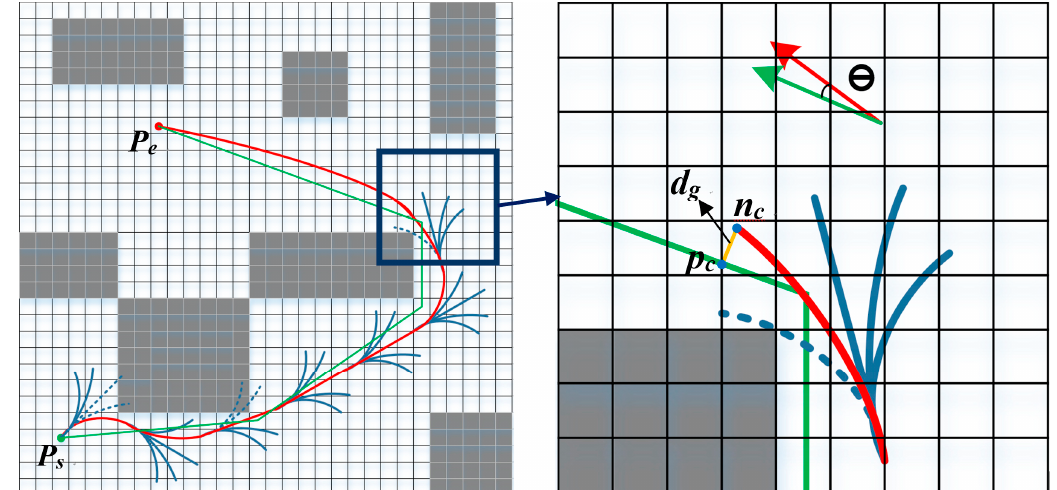
Figure 4. An illustration of the mechanism of the guided kinodynamic path searching (GKPS) method. Blue curves indicate the motion primitives generated by Equation (3). The green path is the guide path generated by pruning A*. The red curve is the result of the search.